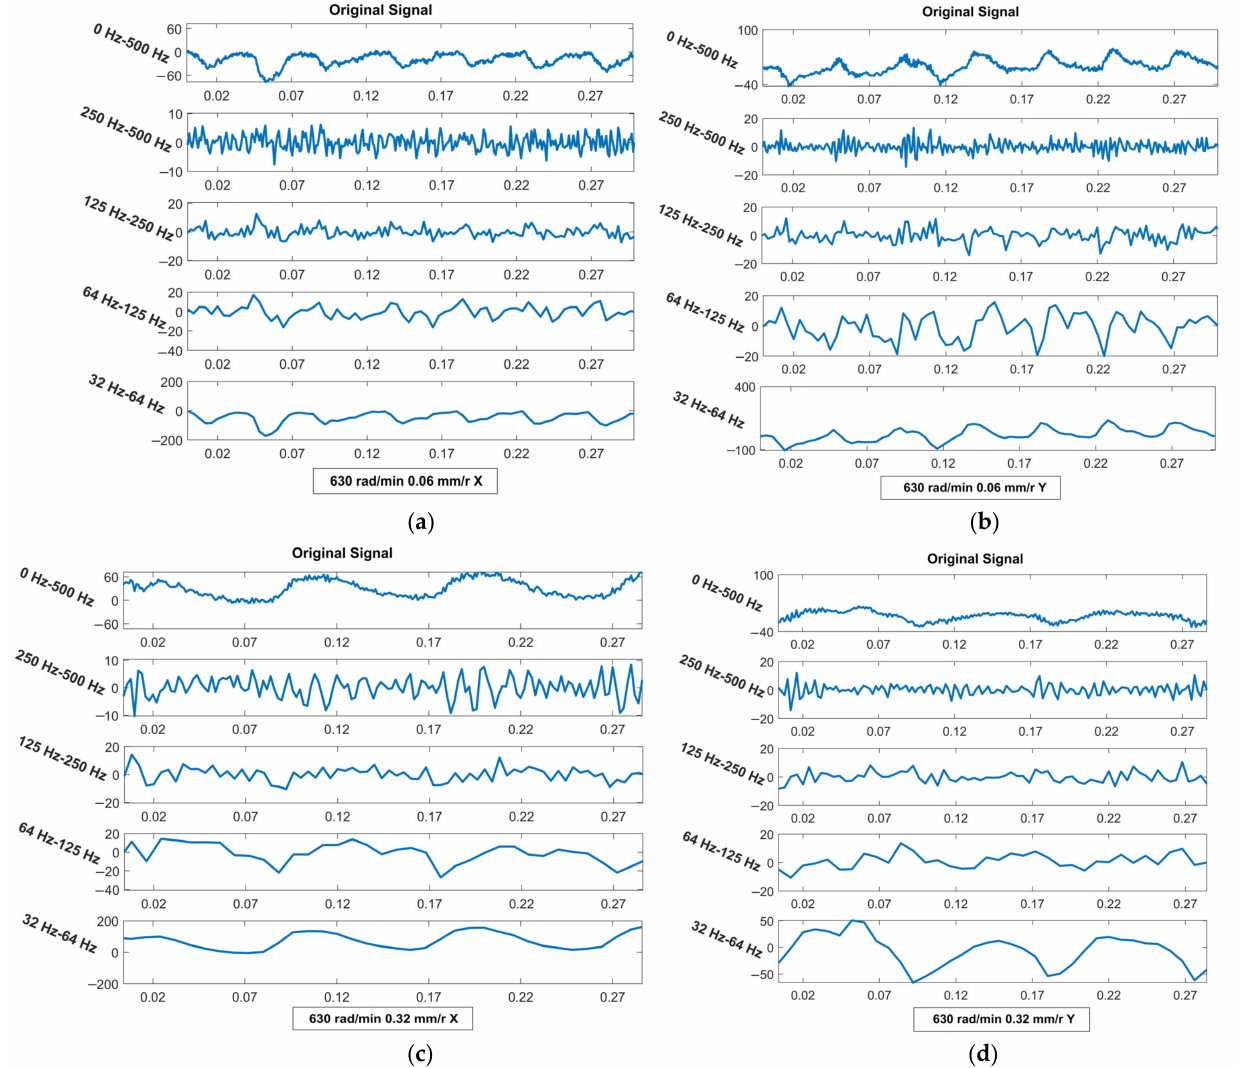
Figure 17. Results of wavelet analysis in the X- and Y-directions when the feed rate is different and the rotational speed is constant. ( a ) Results of wavelet analysis in the X-direction when the feed rate is 0.06 mm/r. ( b ) Results of wavelet analysis in the Y-direction when the feed rate is 0.06 mm/r. ( c ) Results of wavelet analysis in the X-direction when the feed rate is 0.32 mm/r. ( d ) Results of wavelet analysis in the Y-direction when the feed rate is 0.32